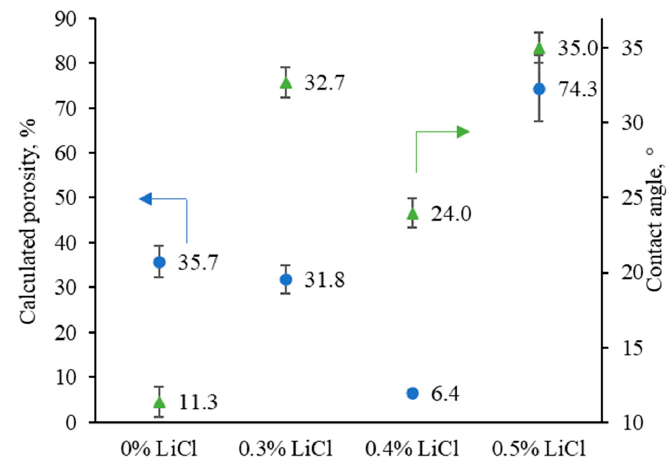
Figure 7. Variations in membranes’ porosity and contact angle as a function of LiCl additive con- centration in the casting solution; the contact angle values of the prepared membranes were rec- orded using the captive bubble method with KSV CAM 101 equipment connected to a CCD camera.